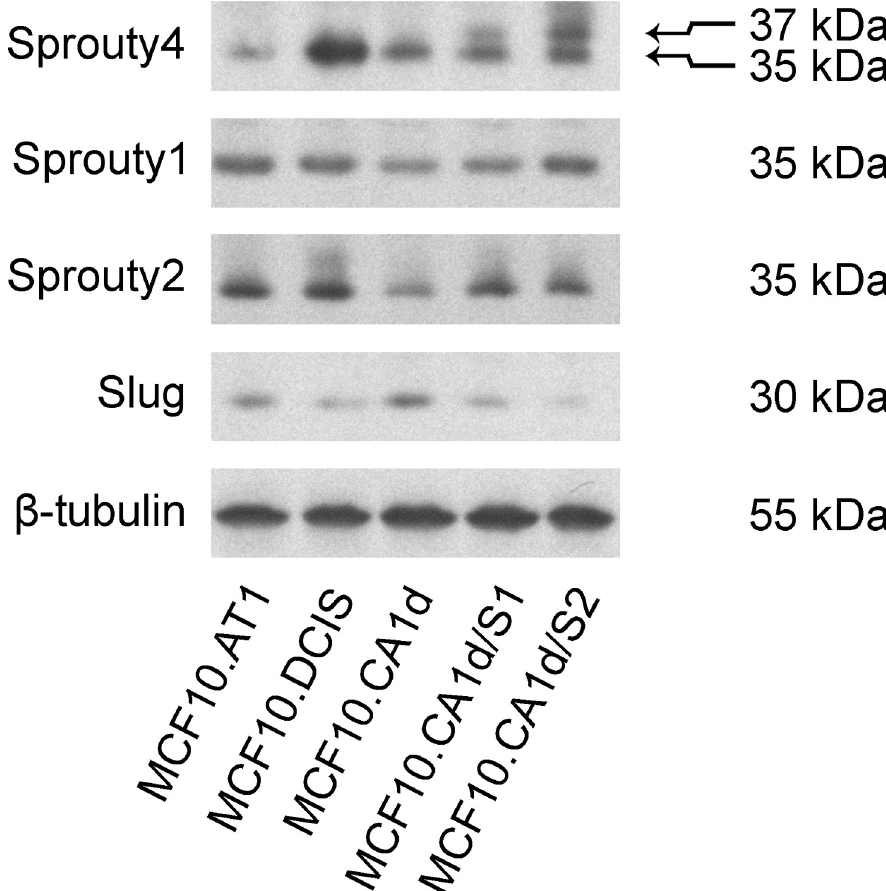
Fig 2. Sprouty4 is highly expressed at the DCIS stage of the MCF10 progression series. The progression series represents triple-negative models of atypical hyperplasia (MCF10.AT1), ductal carcinoma in situ (MCF10.DCIS), and invasive ductal carcinoma (MCF10.CA1d). MCF10.CA1d/S1 (S1) and MCF10.CA1d/S2 (S2) are two independent retroviral overexpressions of Sprouty4 in MCF10.CA1d cells where the transduced Sprouty4 construct migrates at a molecular weight of 37 kDa compared to 35 kDa for endogenous Sprouty4. Cultures were grown in 3D rBM overlay conditions for eight days. Membranes were immunoblotted for Sprouty4, Sprouty1, Sprouty2, Slug, and β -tubulin. Expression levels are representative of three independent